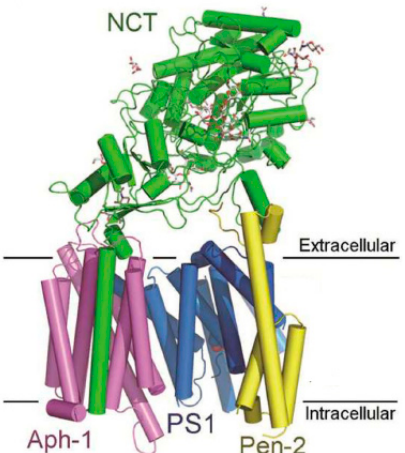
Figure 4. Crystal structure of human γ -secretase. Adapted by permission from Xiao-chen Bai et al. Nature [30], Copyright 2015.